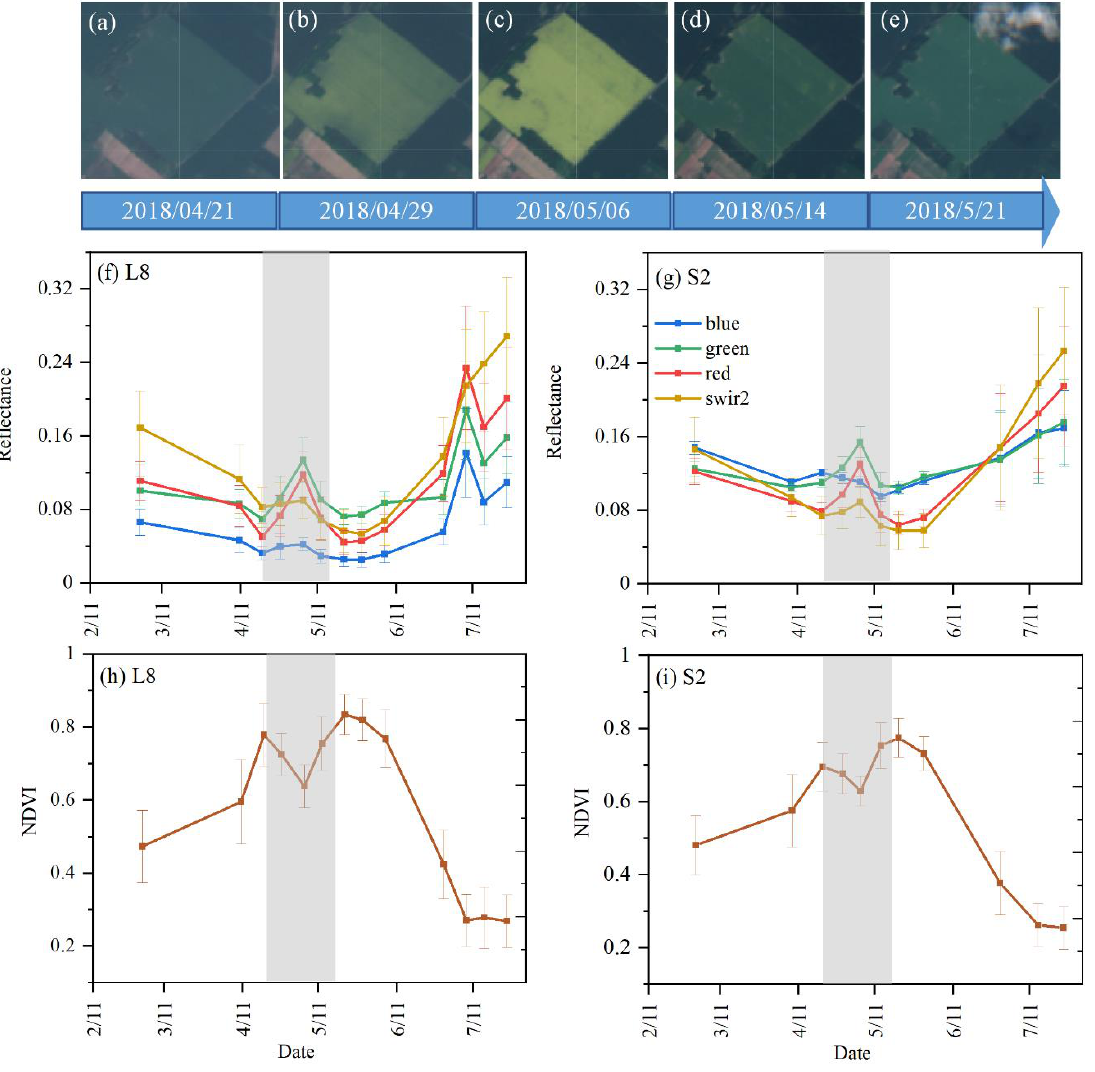
Figure 4. True color images of Sentinel-2 with their dates shot ( a – e ) in 2018 and ( f ) time series of the blue, green, red, and SWIR2 bands of L8; ( g ) the time series of the blue, green, red and SWIR2 bands of S2; ( h ) the time series of L8 the normalized difference vegetation index (NDVI); ( i ) S2 NDVI. The gray area indicates the flowering dates recorded by the DWD stations. Means are indicated by dots and standard deviations by error bars.